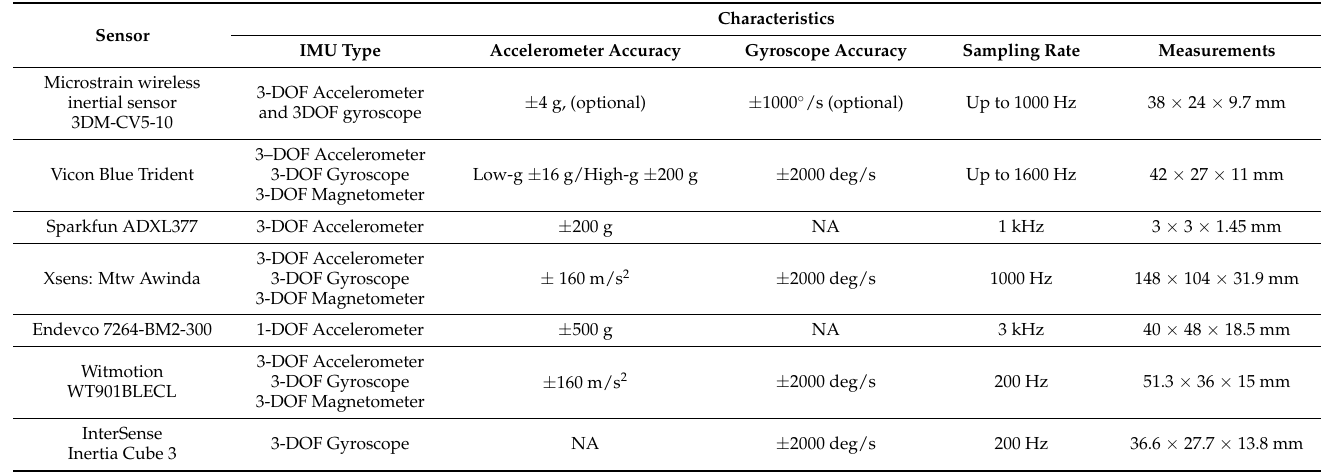
Table 3. Main characteristics of the inertial sensors used in the